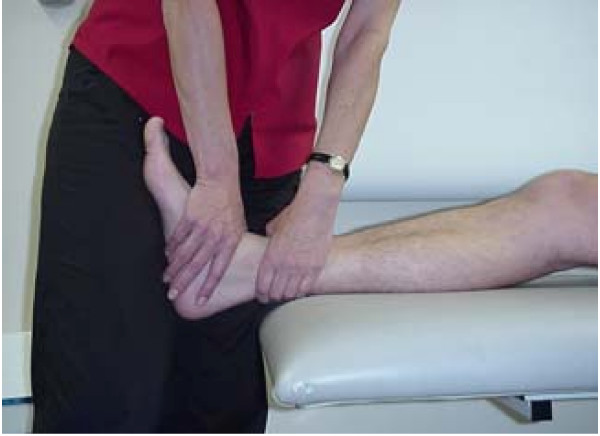
Passive joint mobilisation. The joint mobilisation technique used will be the anterior-posterior glide of the talus. The physiotherapist will apply large amplitude oscillatory movements into resistance (i.e., Grade III) on the talus.